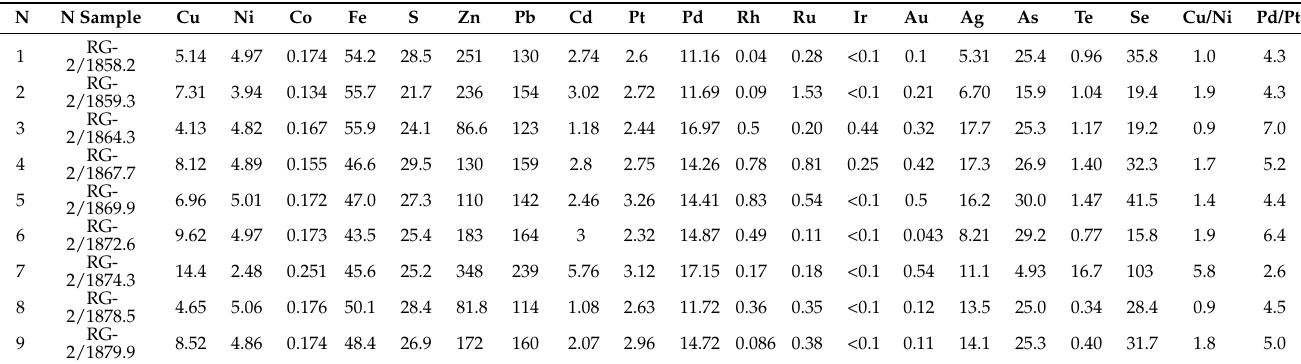
Table 2. Chemical composition of massive ore (orebody